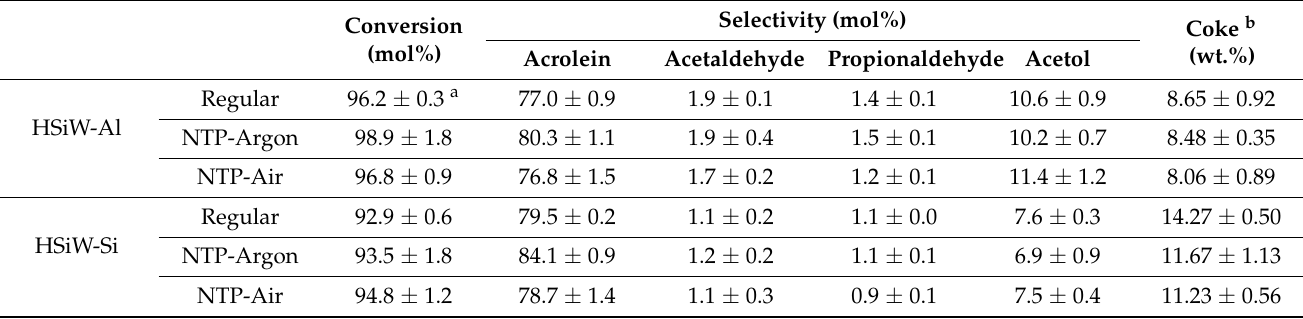
Table 2. Results of glycerol dehydration using HSiW-Al and HSiW-Si